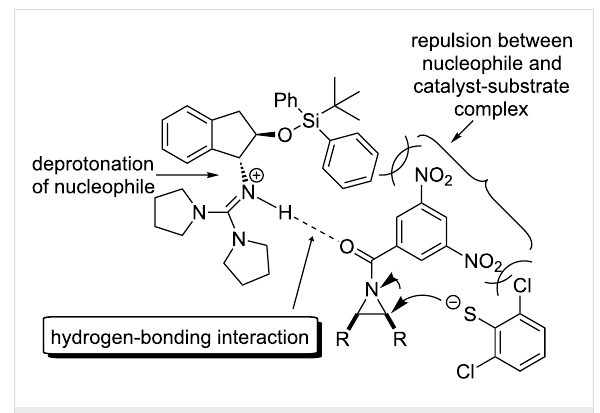
Figure 10: The proposed activation mode of OC-46